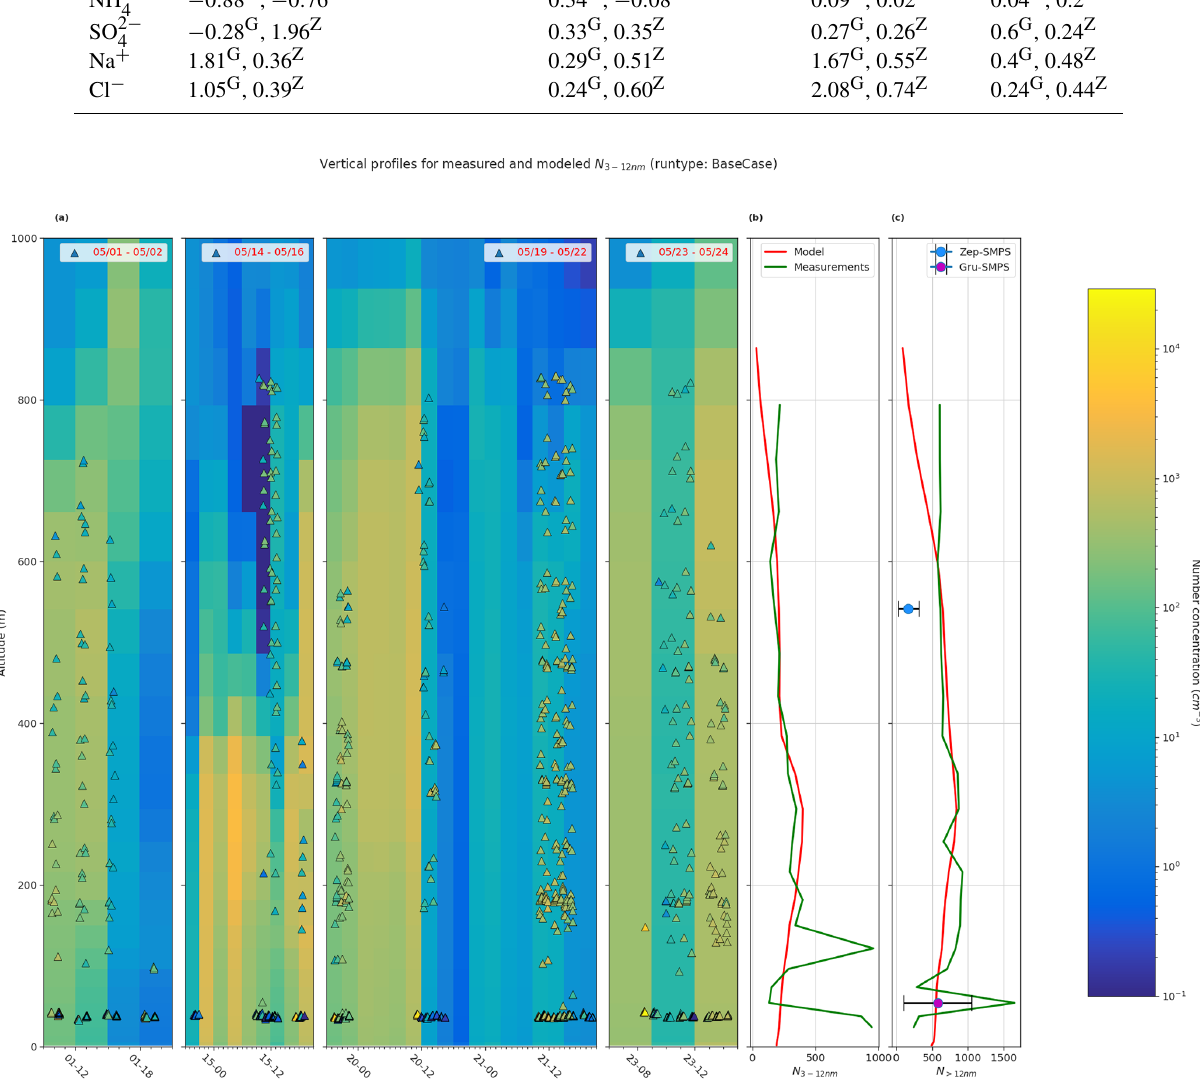
Figure 7. Comparison of vertical profiles of measured particle number concentration and BaseCase simulation. Panel (a) shows measured particle number concentration between 3–12nm ( N 3 − 12nm , triangles), from CPC on board the UAS during the four periods 1–2 May, 14– 16 May, 19–22 May, and 23–24 May (in legend) overlaid onto the simulated N 3 − 12nm for the same periods. Panel (b) shows the simulated and measured mean N 3 − 12nm , and panel (c) shows the N > 12nm for the selected period. Additionally, panel (c) also shows the mean SMPS particle concentrations at both Gruvebadet and Zeppelin. The horizontal bars for the mean SMPS values represent the standard